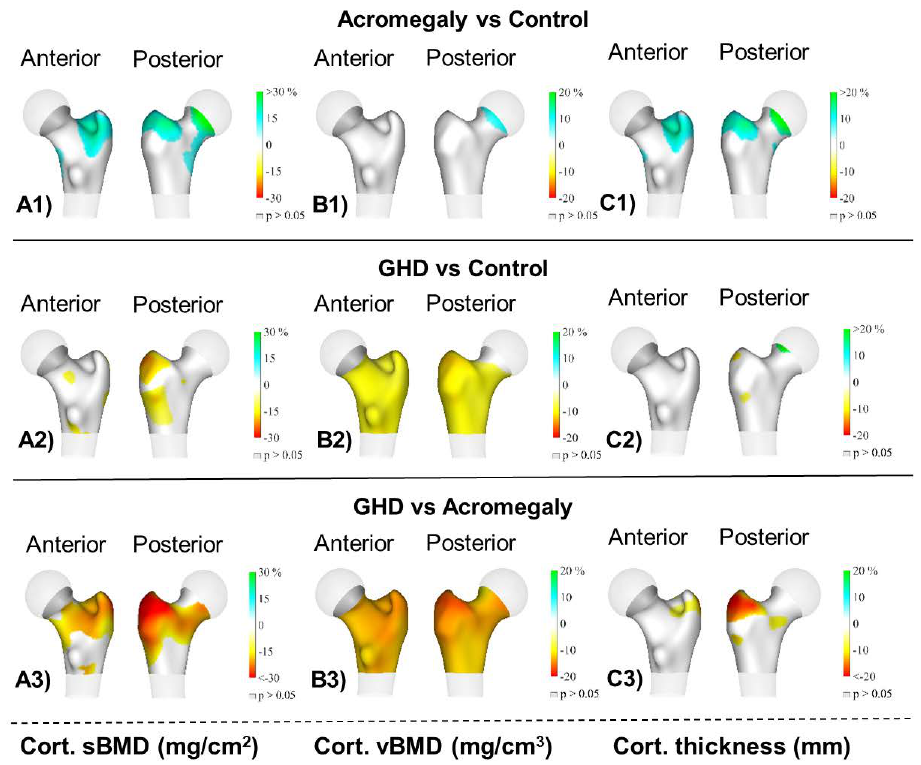
Figure 2. Distribution of the average differences ( p < 0.05) in ( A1 – A3 ) the cortical surface bone mineral density (cortical sBMD), ( B1 – B3 ) cortical volumetric bone mineral density (cortical vBMD) and ( C1 – C3 ) cortical thickness of the total femur region among groups: acromegaly ( n = 20), adult growth hormone deficiency (AGHD, n = 14) and the healthy control group ( n = 33). Regions with no significant differences are coloured in grey ( p >